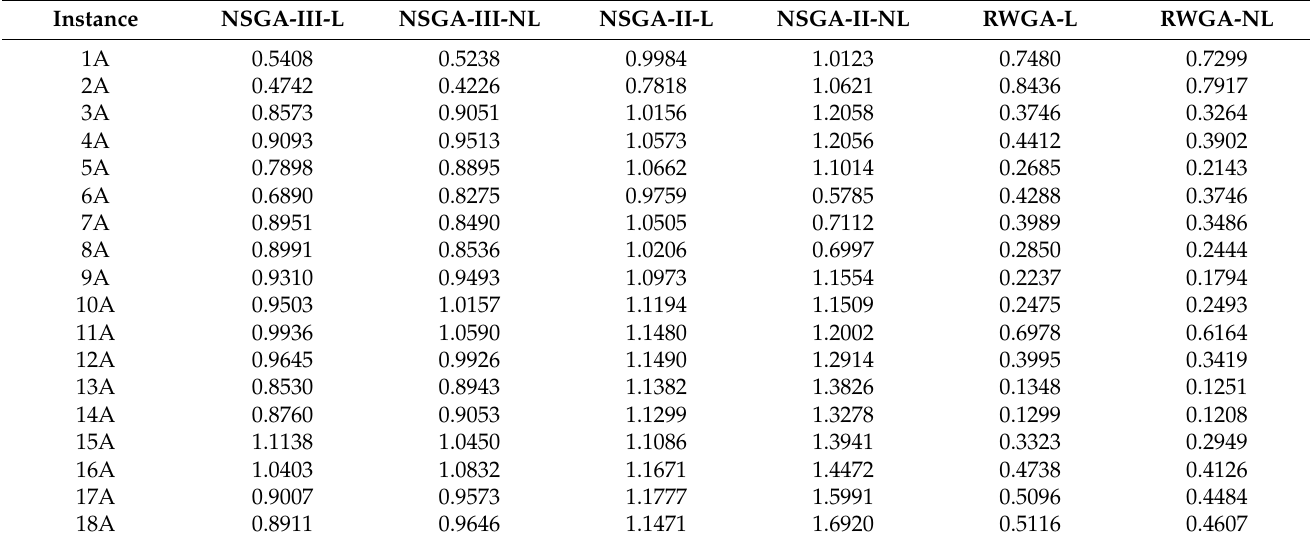
Table 11. Experimental results of MS